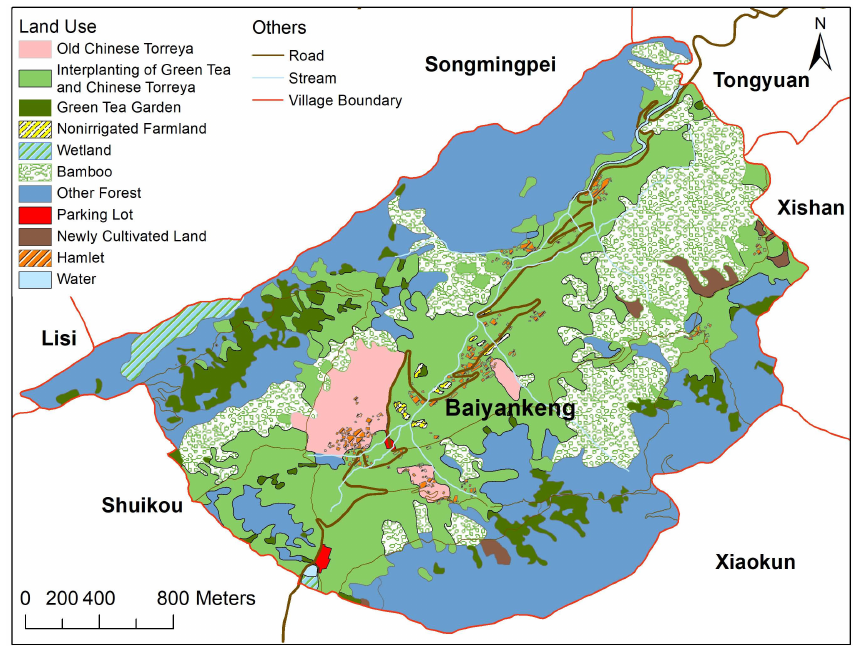
Figure 7. Land use in Baiyankeng village in 2018 (hand-painted according to a remote sensing photo of 0.5 m/pixel taken on 20 April 2018, provided by the former Bureau of Surveying, Mapping and Geographic Information of Zhejiang Province).